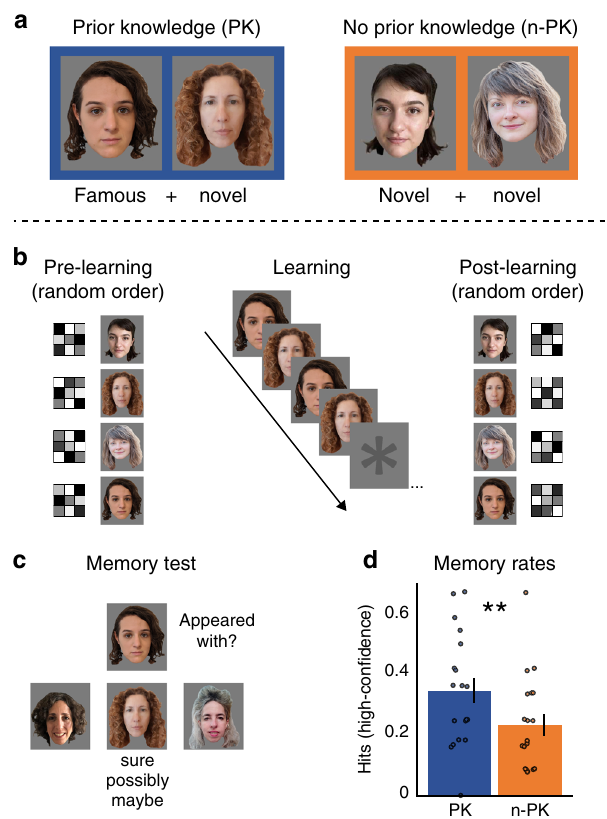
Fig. 1 Design and behavior. a Experimental conditions: participants learned pairs of faces, either a famous and a novel face in the prior-knowledge condition (PK), or two novel faces in the no-prior-knowledge condition (n- PK). b While in the scanner, participants viewed the pairs 12 times in 12 cycles; each cycle included all pairs in a random order. Before and after associative learning, participants in the scanner also viewed each face presented alone, in random order. This allowed us to capture the multivoxel activity pattern of each face, for pattern similarity analysis (see Methods). c After the post-learning scan, participants performed an associative memory test, in which they indicated which of the three bottom faces appeared with the face on the top and rated their con fi dence (sure/ possibly/maybe). d Behavioral results of the associative memory test. High- con fi dence hits include “ sure ” and “ possibly ” responses. ** P = 0.01, the results of a paired-sample two-tailed t test between PK and n-PK pair type. Data are presented as mean values, error bars re fl ect + / − SEM. To protect copyrights, all faces in the fi gures are of novel faces, and we obtained permission to use these photos. Participants in the study saw famous and novel faces, as detailed in